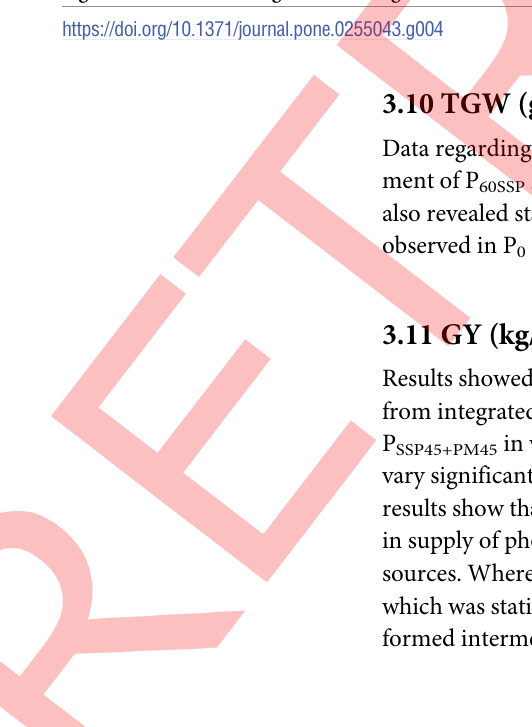
Fig 4. Effect of various organic and inorganic nutrient sources on leaf area of